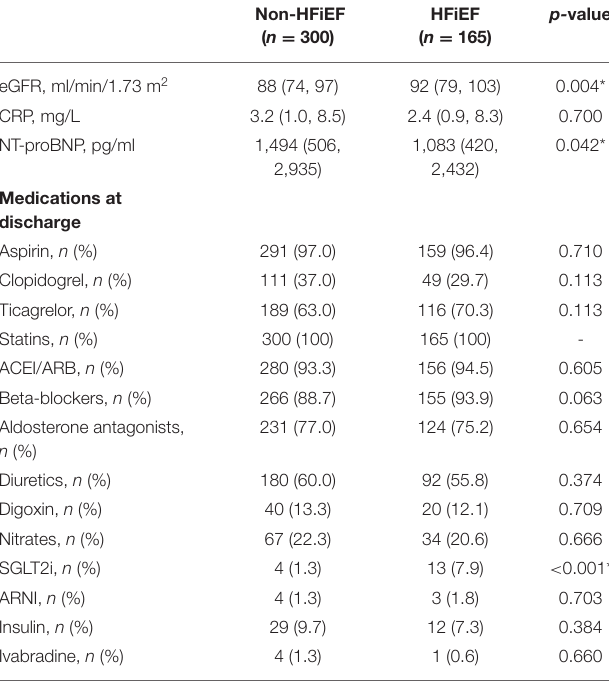
TABLE 1 | Clinical